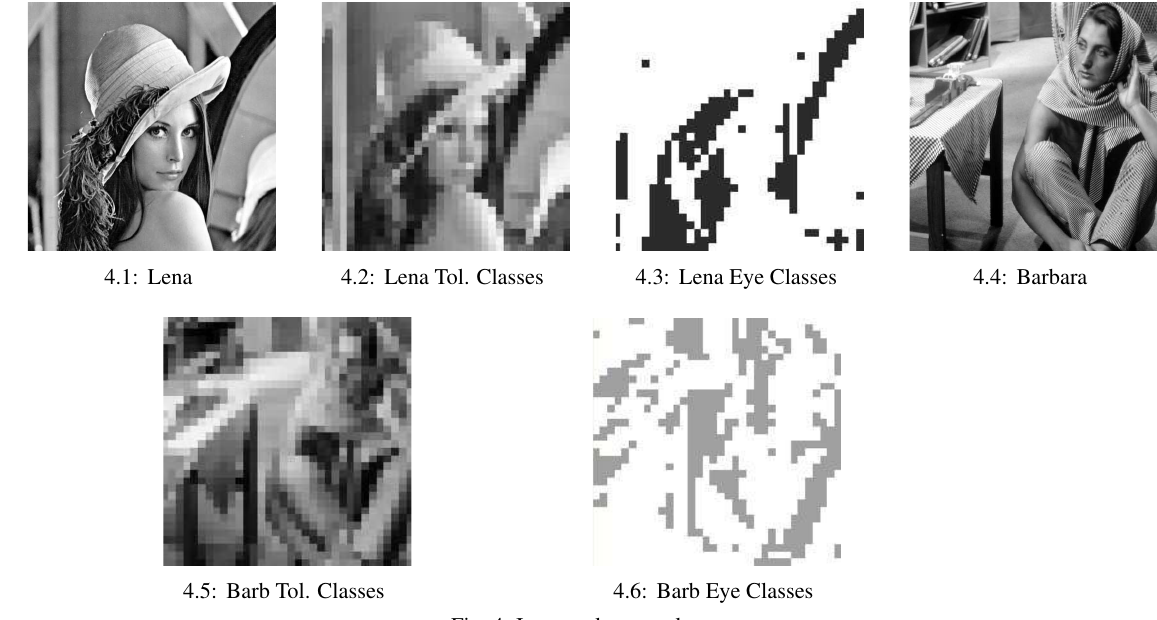
Fig. 4. Image tolerance